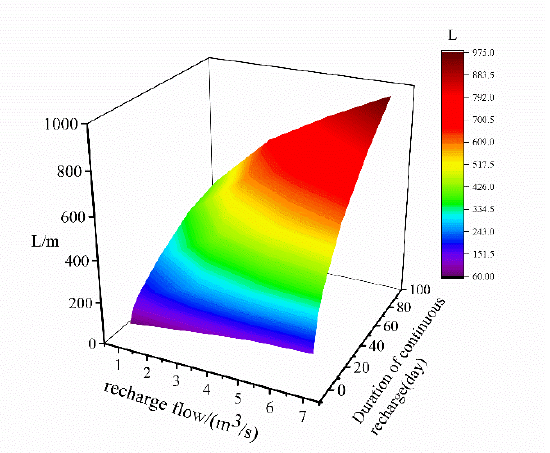
Figure 13. Horizontal maximum diameter change diagram.